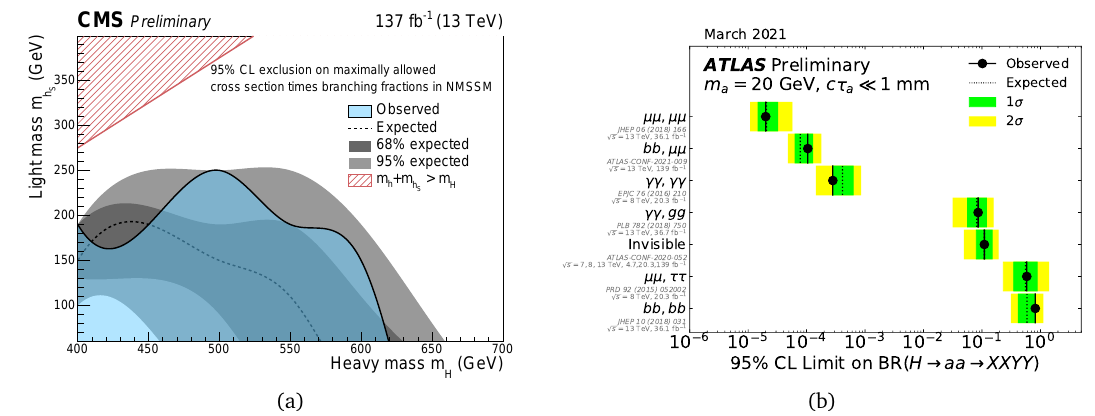
Figure 2: Measured 95% confidence level exclusion limits of searches for BSM physics. Left: Exclusion limits for the production of new Higgs bosons H and h S h → ττ bb events interpreted within as a function of their respective mass in H → h s the NMSSM model (CMS [ 27 ] ). Right: Summary of upper limits on SM Higgs boson decays to new light scalars in various decay channels (ATLAS [ 32 ]